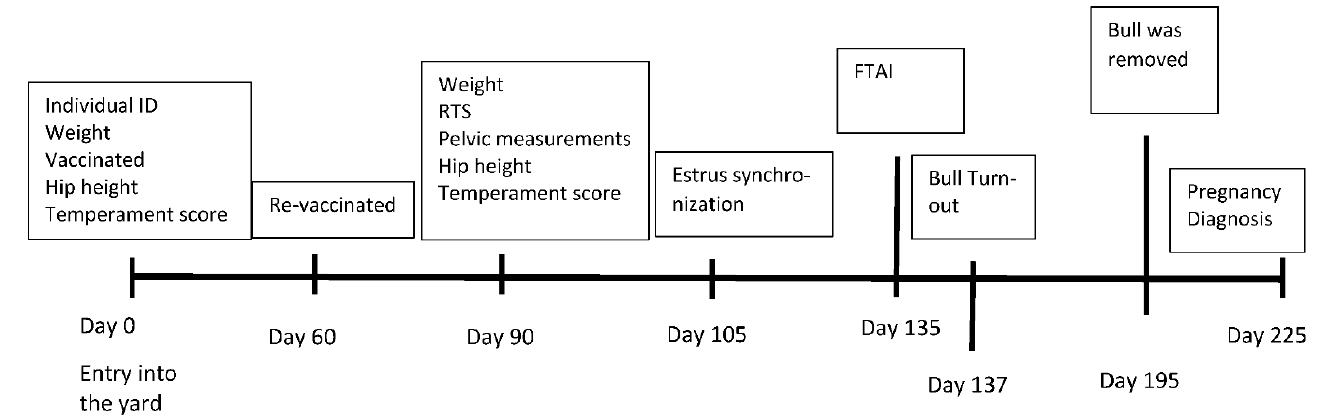
Figure 1. Timeline of measurements and events for the heifer development yard. RTS- reproductive tract score, FTAI- Fixed timed AI.